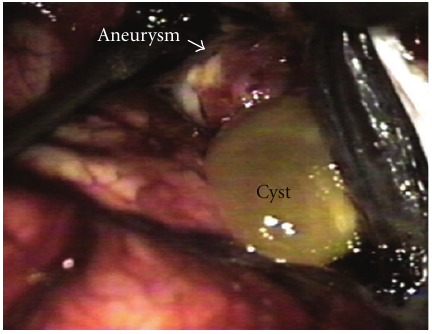
Figure 2: Operative photography of the cyst and the aneurysm.